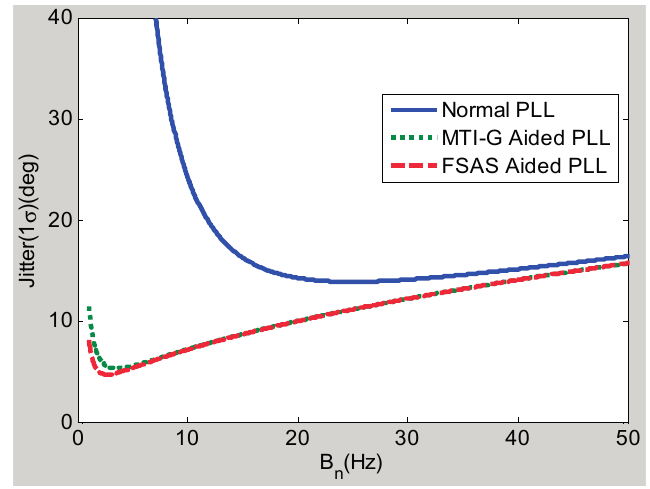
Figure 9. Steady-state tracking errors with the acceleration of 9.8 m/s 2 and CNR of 30